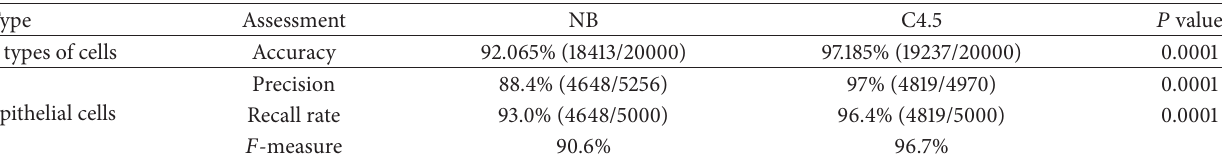
Table 2: The accuracy of the four types of cells and the precision, the recall rate, and the 𝐹 -measure of epithelial cells, from Step 1 classification.